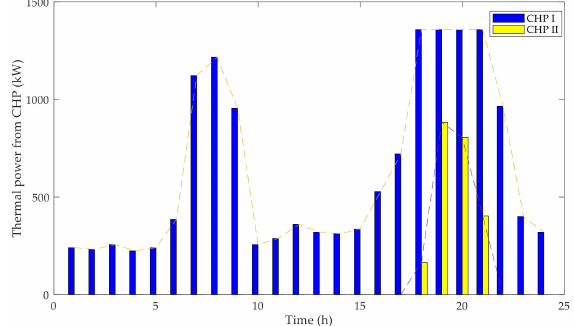
Figure 17. Thermal power supply from CHP_I and CHP_II in Case 2.